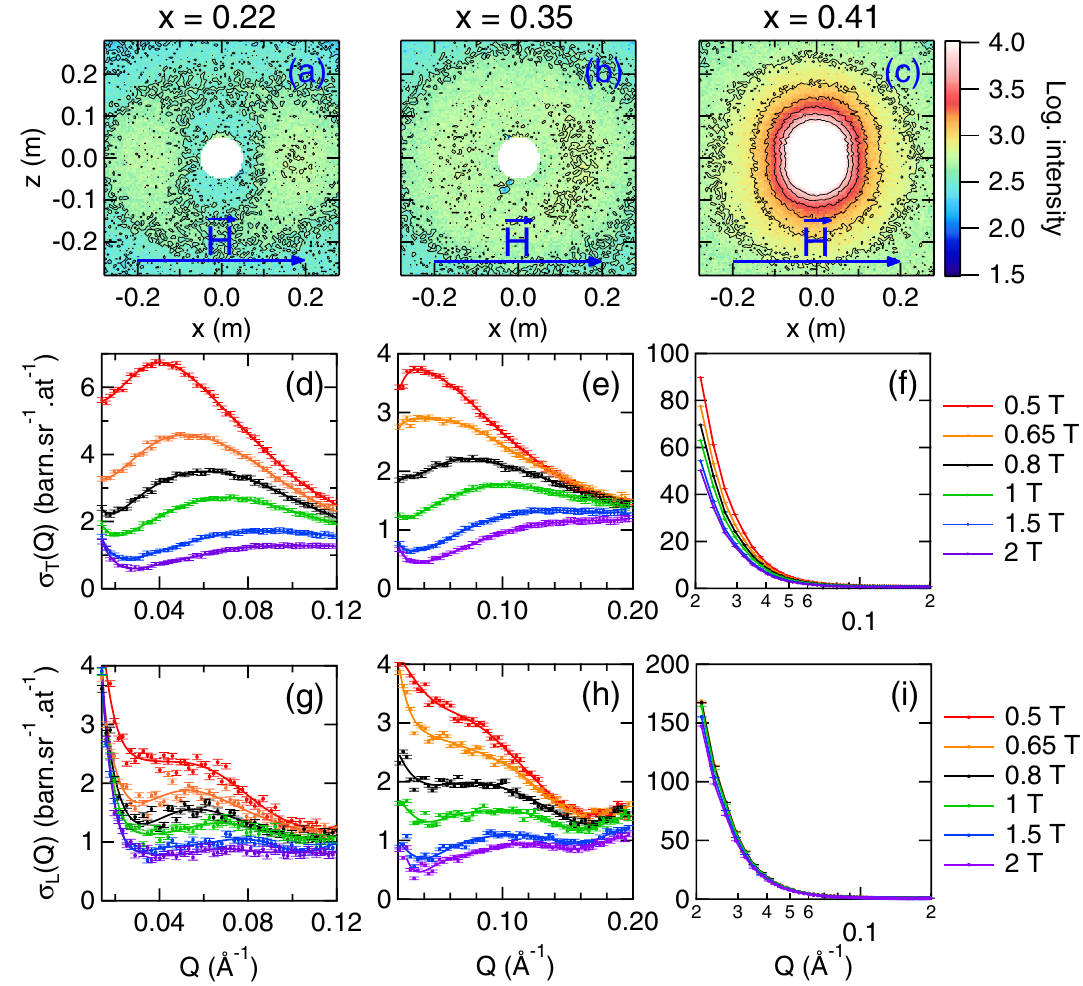
Figure 2. SANS data on a-Fe 1 − x Mn x in the M2 and SG phases—( a–c ) Scattering maps recorded at T = 5 K under an applied magnetic field of 1.5 T. ( d–f ) Field-dependence of the transverse magnetic cross section σ T ( Q ) ( g-i ) Field-dependence of the longitudinal magnetic cross section σ L ( Q ) . The values of the applied magnetic field are indicated for panels ( d–i